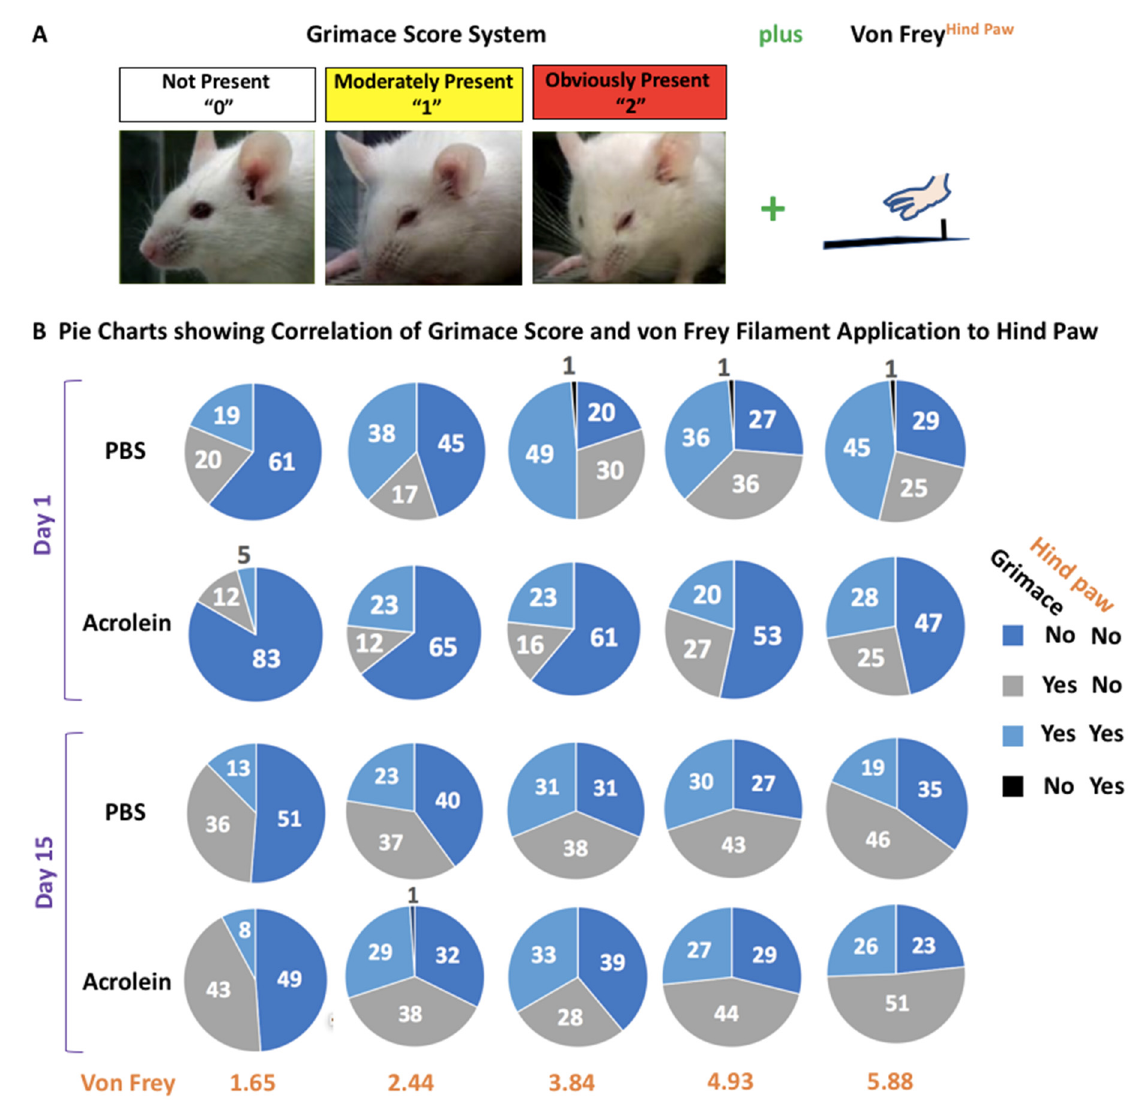
Figure 8. Facial expression of pain and peripheral sensitivity determined by the grimace scoring system and von Frey application to the hind paw. ( A ) Description of the grimace scoring system with a combination of von Frey application to the hind paw. ( B ) Pie charts showing the percentage (%) of mice determined to be neither grimace scored nor responsive to von Frey filaments (dark blue), to be grimace scored but not be responsive to von Frey filaments (gray), to be grimace scored and responsive to von Frey filaments (light blue), and to be not grimace scored but responsive to von Frey filaments (black) on days 1 and 15.